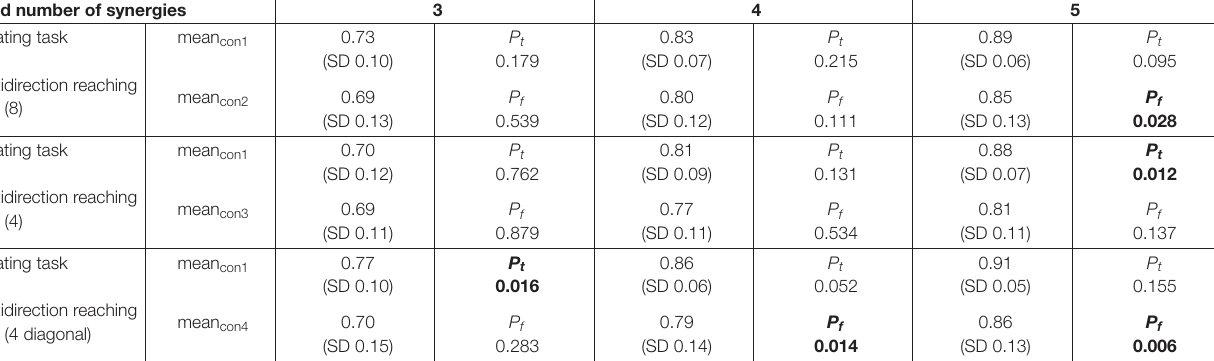
TABLE 2 | The result of electromyography (EMG) activity reconstruction comparison between the rotating task (condition 1) and the multidirection reaching task (conditions 2, 3, and 4) in each fixed synergy number. Fixed number of